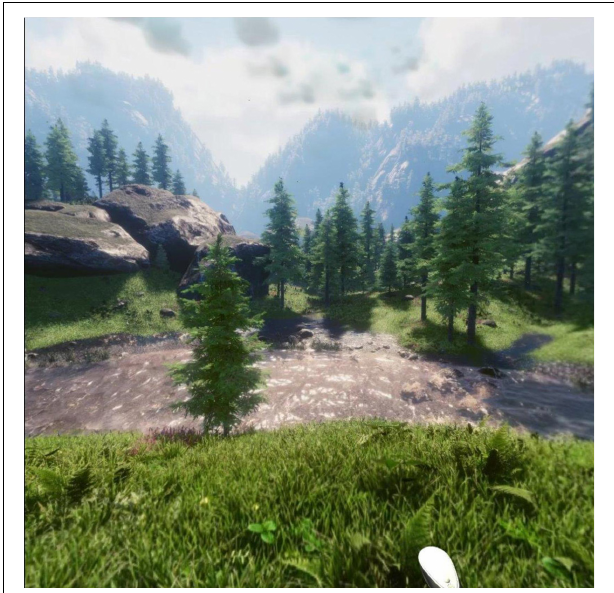
FIGURE 2 | Screenshot of VR environment